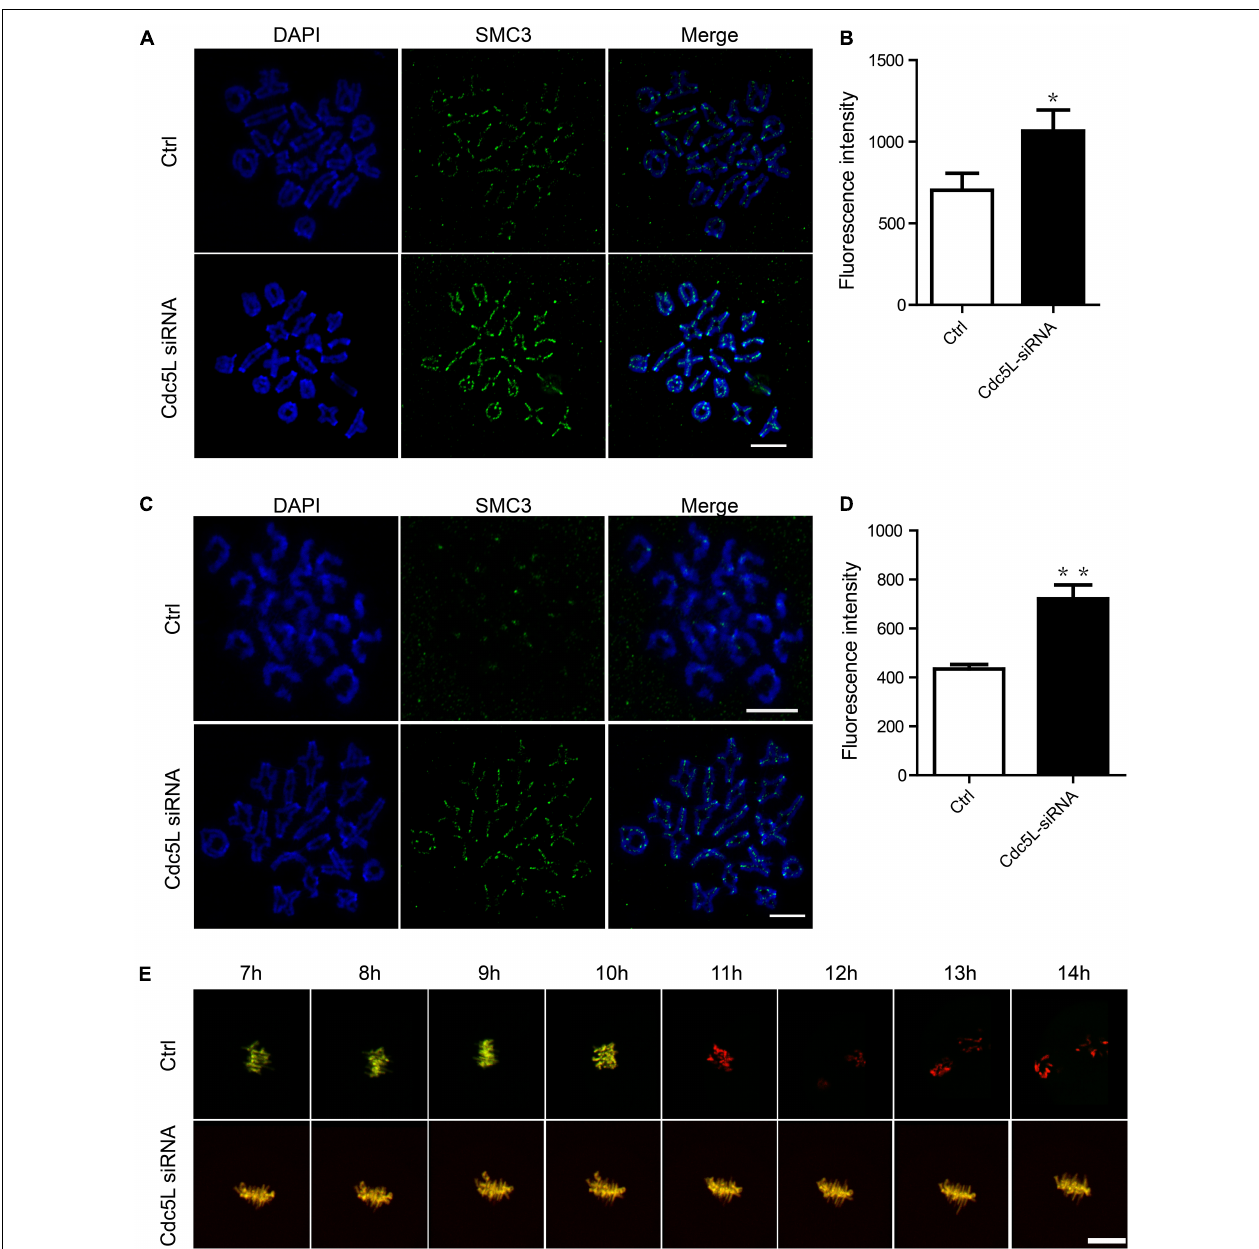
FIGURE 3 | Activity of separase during meiosis I in mouse oocytes. (A) Chromosome spread and SMC3 detection in control ( n = 18) and Cdc5L knockdown ( n = 20) oocytes. Oocytes were collected at 10 after release from IBMX. ACA, anti-centromeric antibody. Scale bars: 10 µ m. (B) Analysis of SMC3 density in oocytes at 10 h after release from IBMX. Data are shown as means ± SEM. “*” represents P < 0.05; “**” represents P < 0.01. At least three replications were conducted. Oocytes were analyzed for each group as follows: Ctrl, n = 18; Cdc5L siRNA, n = 20. (C) Chromosome spread and SMC3 detection in control ( n = 21) and Cdc5L knockdown ( n = 20) oocytes. Oocytes were collected at 14 after release from IBMX. ACA, anti-centromeric antibody. Scale bars: 10 µ m. (D) Analysis of SMC3 density in oocytes at 14 h after release from IBMX. Data are shown as means ± SEM. “*” represents P < 0.05; “**” represents P < 0.01. At least three